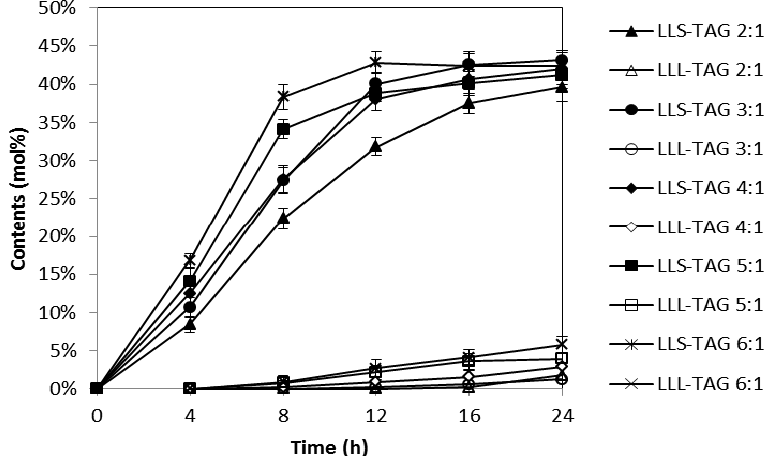
Figure 2. Effect of substrate molar ratio on the production of SLCTs. The reaction mixture containing different molar ratios of FAMEs/triacetin and 2% (w/w) Novozyme 435 was incubated at 40 °C. LLS-TAG 2:1, 3:1, 4:1, 5:1 and 6:1 the content of LLS-TAGs at molar ratio of FAMEs/triacetin from 2:1 to 6:1, respectively; LLL-TAG 2:1, 3:1, 4:1, 5:1 and 6:1 the content of LLL-TAGs at molar ratio of FAMEs/triacetin from 2:1 to 6:1,